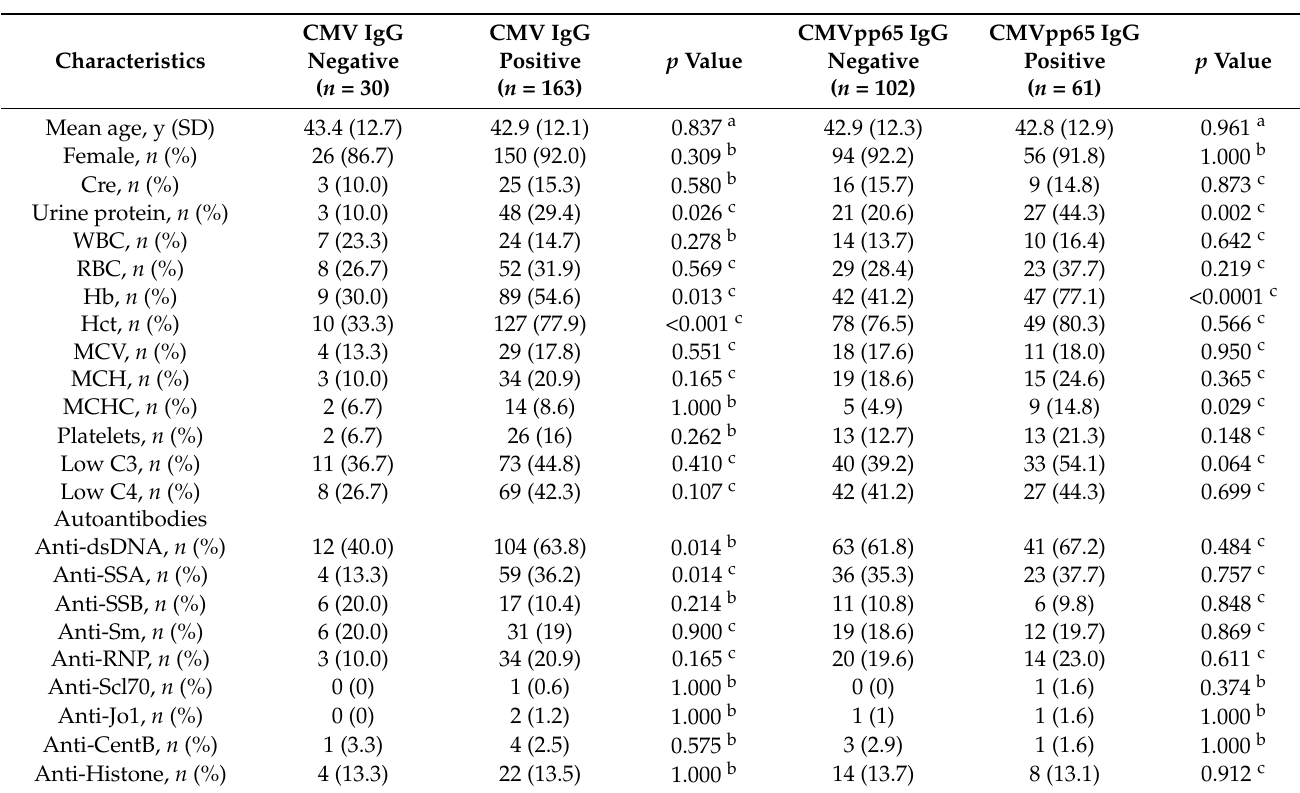
Table 2. Comparison of hematological and serological abnormalities in SLE patients in the presence or absence of IgG antibody to CMV and